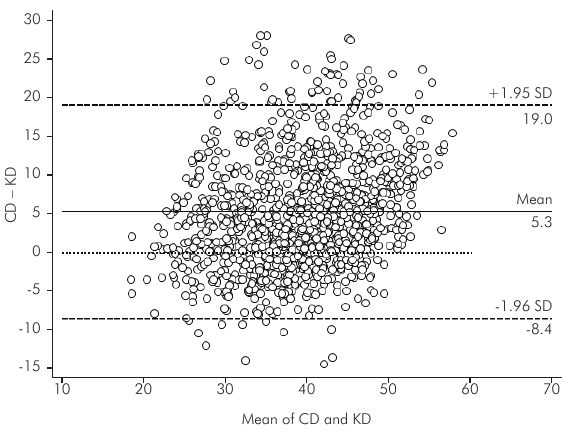
Figure 2. Bland Altman agreement analysis. Mean differences between both methods, Kvaal (K) and Cameriere (C).